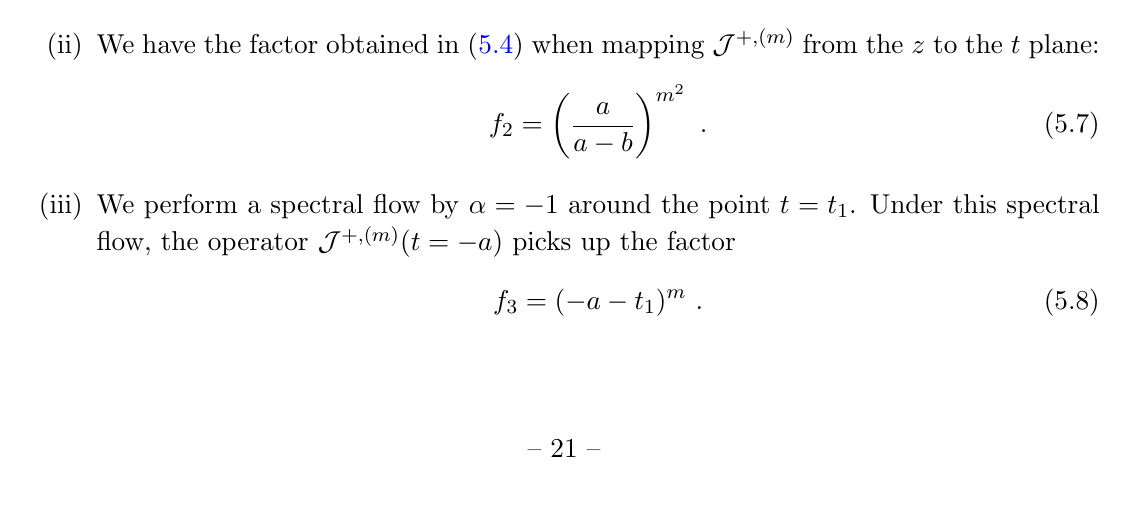
Figure 5 . (a) The t plane with the spin (cid:12)elds S + ( t 1 ) and S (cid:0) ( t 2 ), the G (cid:0) G + contour circling t 2 , the J + ;m contour circling t = (cid:0) a , and the J (cid:0) ;m contour circling t = 1 . _ C (b) The spin (cid:12)elds, S + ( t 1 ) and S (cid:0) ( t 2 ) spectral (cid:13)owed away. (c) The spin (cid:12)elds S + ( t 1 ) and S (cid:0) ( t 2 ) and the currents J + ;m and J (cid:0) ;m all spectral (cid:13)owed away. All of the spectral (cid:13)ow factors are given in subsection